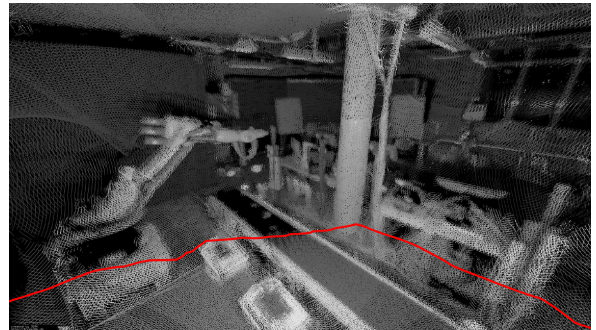
Figure 6. 3D point cloud of the laboratory. In the foreground, the trajectory is shown in